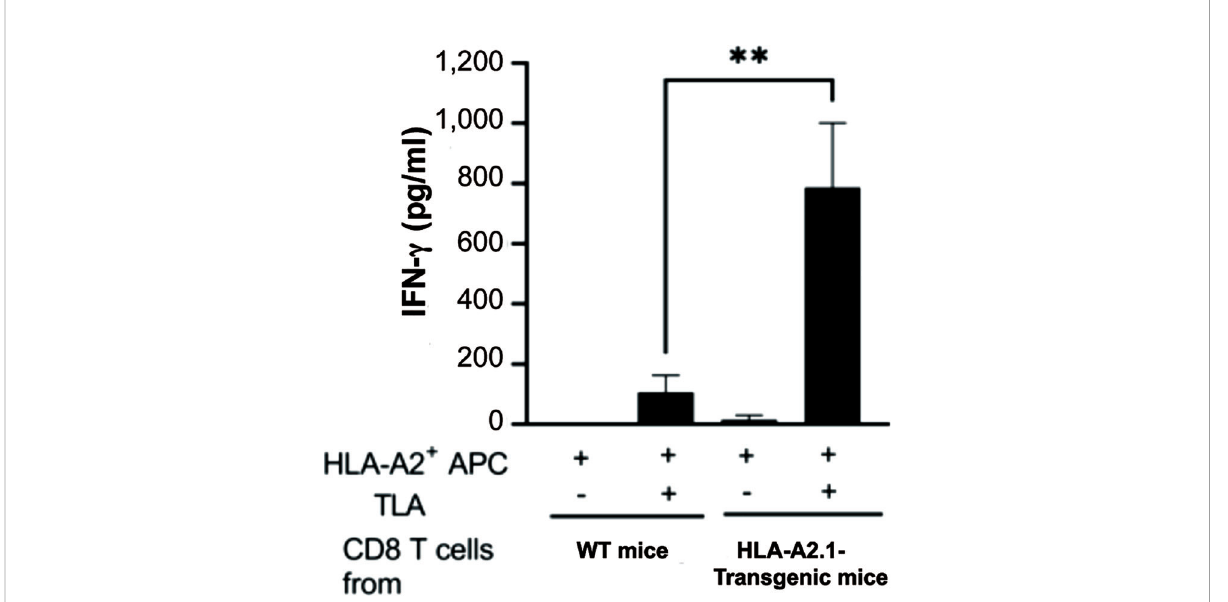
FIGURE 5 CD8 + T cells from T. gondii -infected HLA-A2.1-transgenic mice produce larger amounts of IFN- g than do the T cells from infected WT control mice in response to tachyzoite antigens in the presence of antigen-presenting cells expressing HLA-A2.1. CD8 + T cells were puri fi ed from the spleens of four mice in each of the HLA-A2.1 and WT mouse groups at 3 weeks after infection, and those T cells (3 x 10 5 cells) were stimulated with total tachyzoite lysate antigens (TLA) (10 m g/ml) in the presence of the HLA-A2.1-expressing antigen-presenting cells (1.5 x 10 5 cells) for 72 hrs. The amounts of IFN- g in the culture supernatants were measured by ELISA. ** P